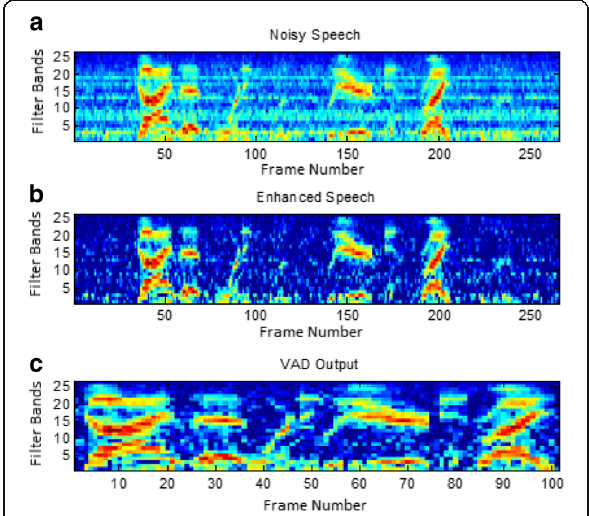
Fig. 6 a Noisy speech signal with a 0 dB overall SNR, b enhanced speech signal, and c final VAD output (only the frames detected as speech-dominant) of the proposed algorithm